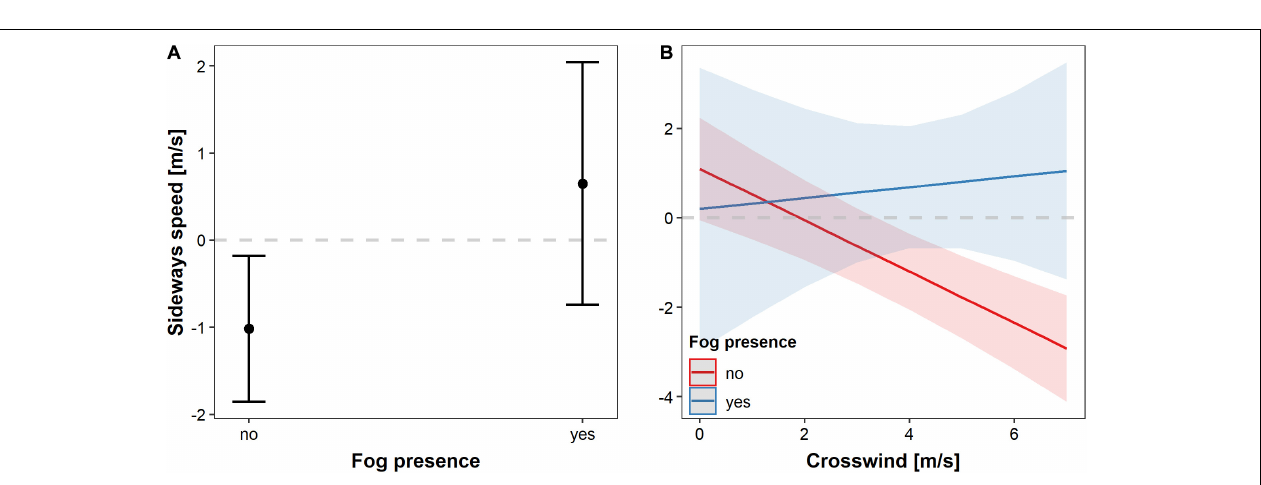
FIGURE 4 | The effects of crosswind and tailwind speed on airspeed of Honey Buzzards migrating through fog or under clear skies. (A) Regression slope and 95% C.I. of the airspeed in relation to tailwind. (B) Regression slopes and 95% C.I. of the airspeed in relation to crosswind in foggy conditions (blue) and clear weather (red). Crosswinds all have positive values since they only represent wind blowing from the left to the right side of the average migration direction.